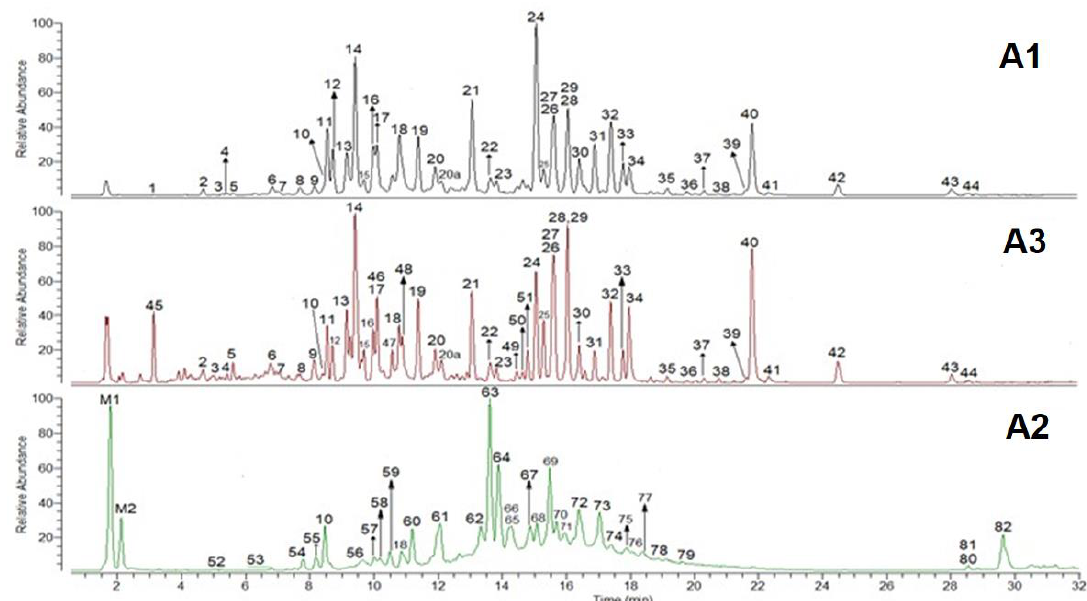
Figure 1. The total ion chromatography, 100–2000 u, of cranberry extracts A1, A2, and A3. See Table 2 for peak identifications.